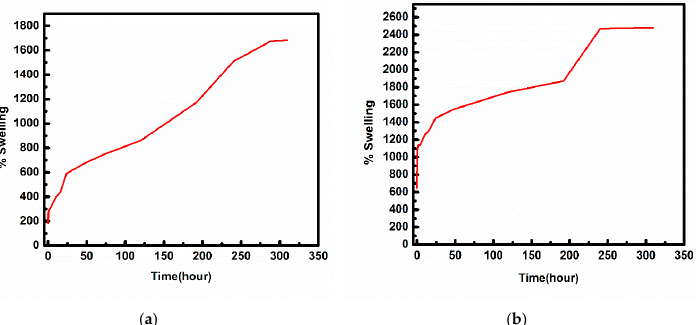
Figure 5. % Swelling of hydrogel grafted silk fabric, ( a ) 5% ( b ) 25% APS.